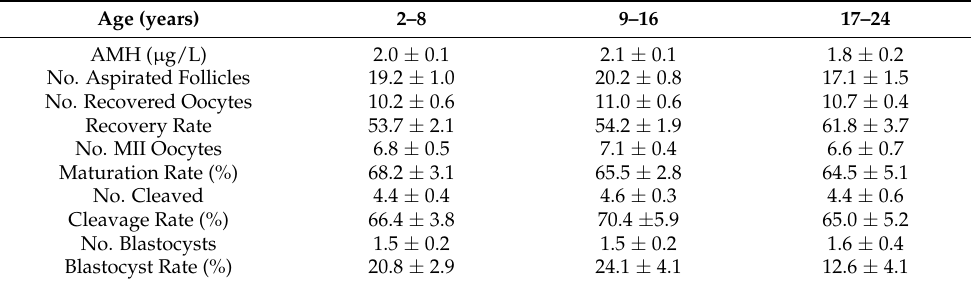
Table 2. Effect of maternal age on OPU-ICSI